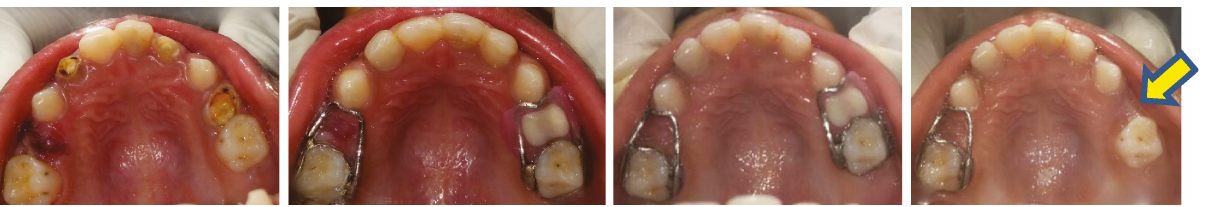
Figure 4: Preoperative, immediate postoperative, and one-year postoperative occlusal views of the maxillary arch with the conventional band and loop space maintainer in the tooth 54 region and functional band and loop space maintainer in the tooth 64 region. Note the absence of tissue changes